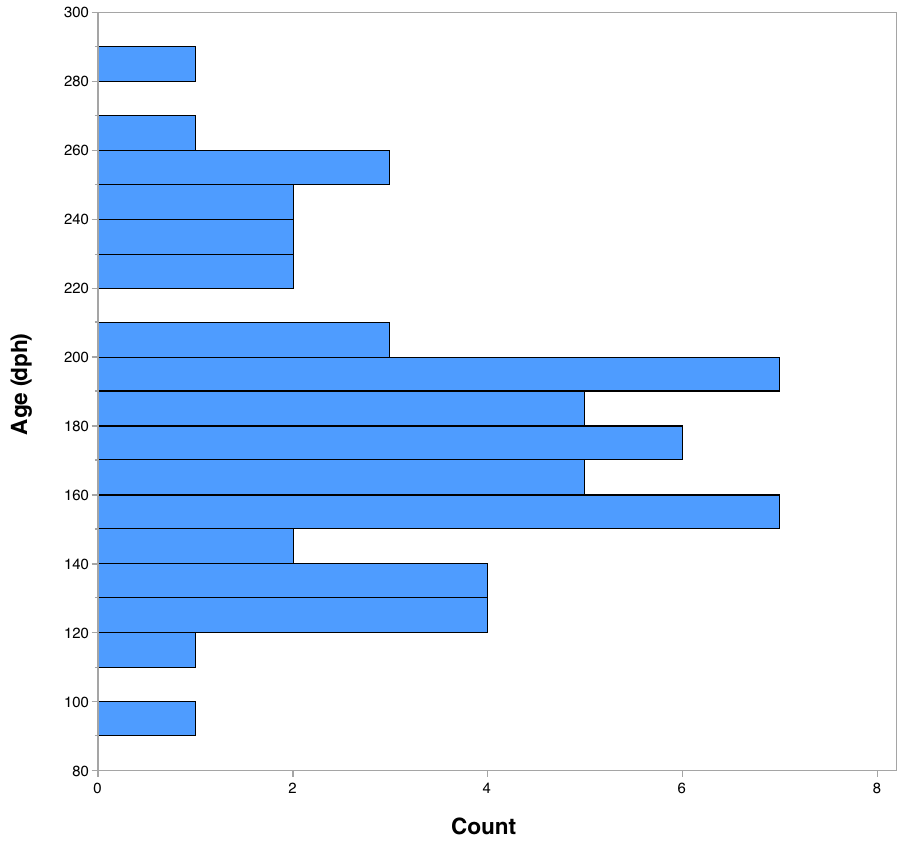
Figure 6. Age-frequency distribution of geochemical changepoints for Pacific bluefin tuna detected using otolith Mg:Ca, Mg:Ca, and Sr:Ba. Estimated changepoint age of each individual was based on average from all three